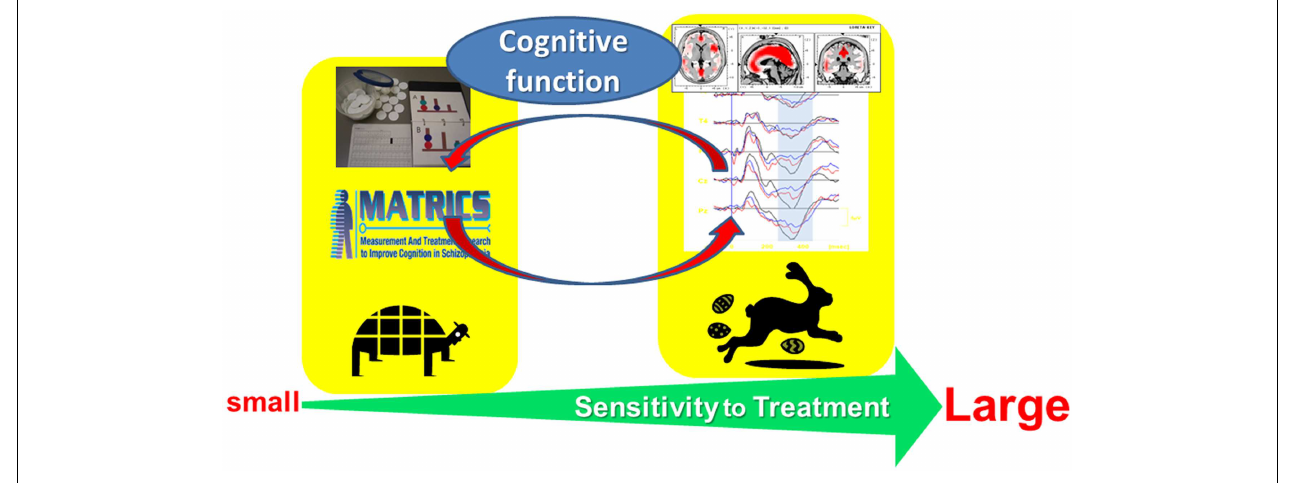
FIGURE 1 | Electrophysiological approach toward cognitive assessment in schizophrenia .This strategy is expected to facilitate (1) elucidation of mechanisms of cognitive enhancement, (2) rational choice of psychotropic drugs, and (3) prediction of functional